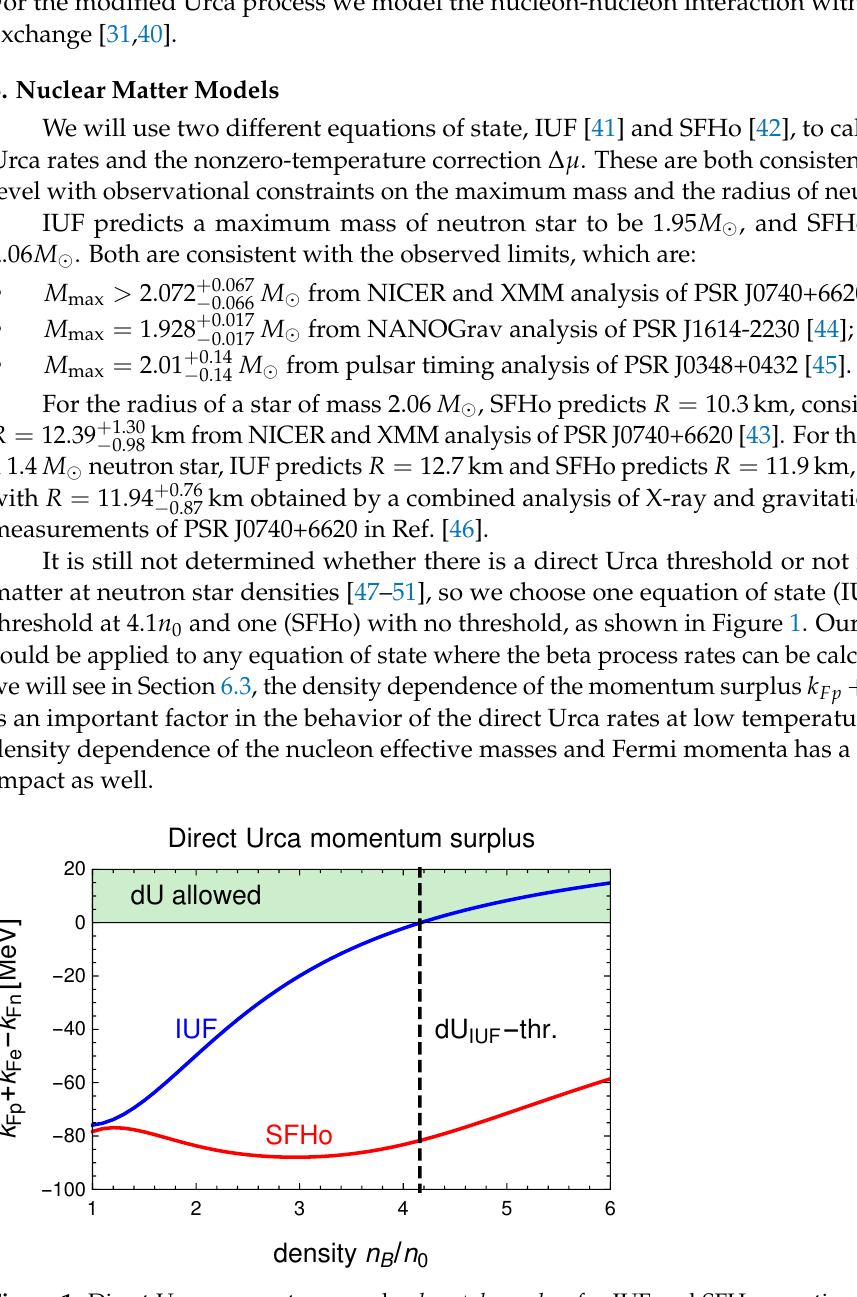
Figure 1. Direct Urca momentum surplus k Fp + k Fe − k Fn for IUF and SFHo equations of state at T = 0. When the surplus is negative, direct Urca is forbidden. IUF has an upper density threshold above which direct Urca is allowed; SFHo does